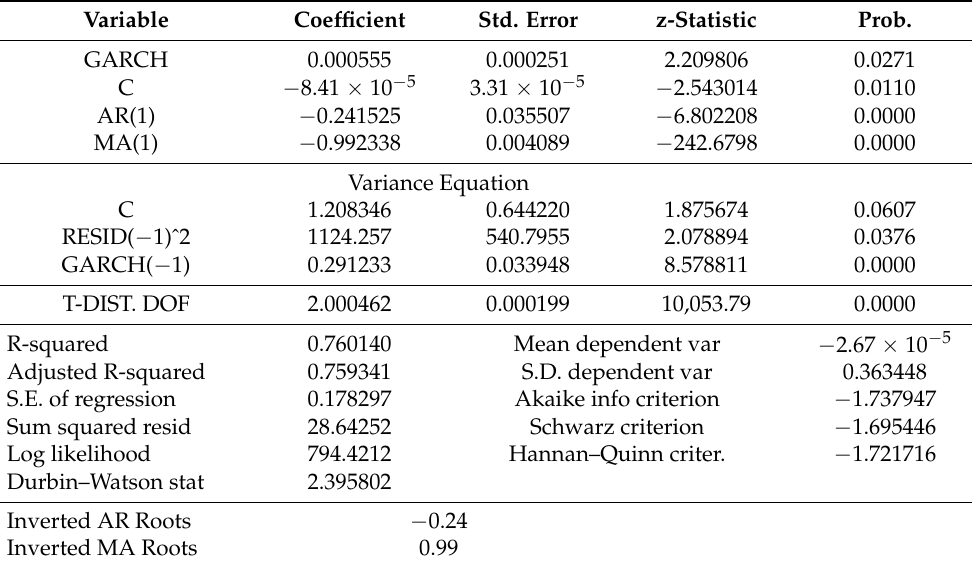
Table 6. GARCH-M Model for risk-return